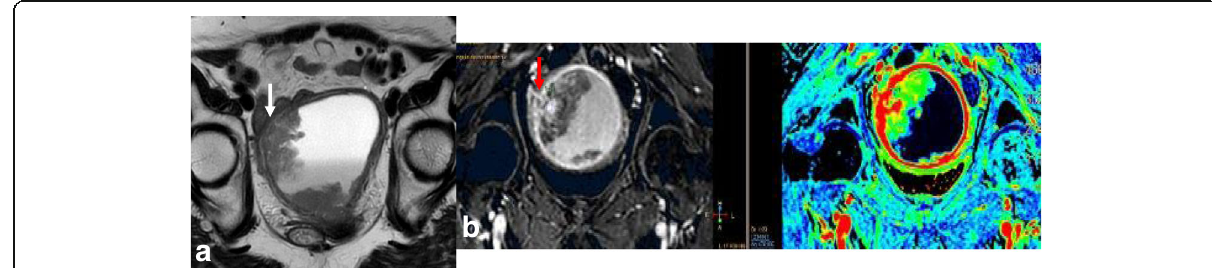
Fig. 6 Endometrial cancer with endometrial cavity distension. a Axial oblique T2WI. b DCE and parametric map. Disruption of the endometrial – myometrial zone (arrows) indicates myometrial invasion